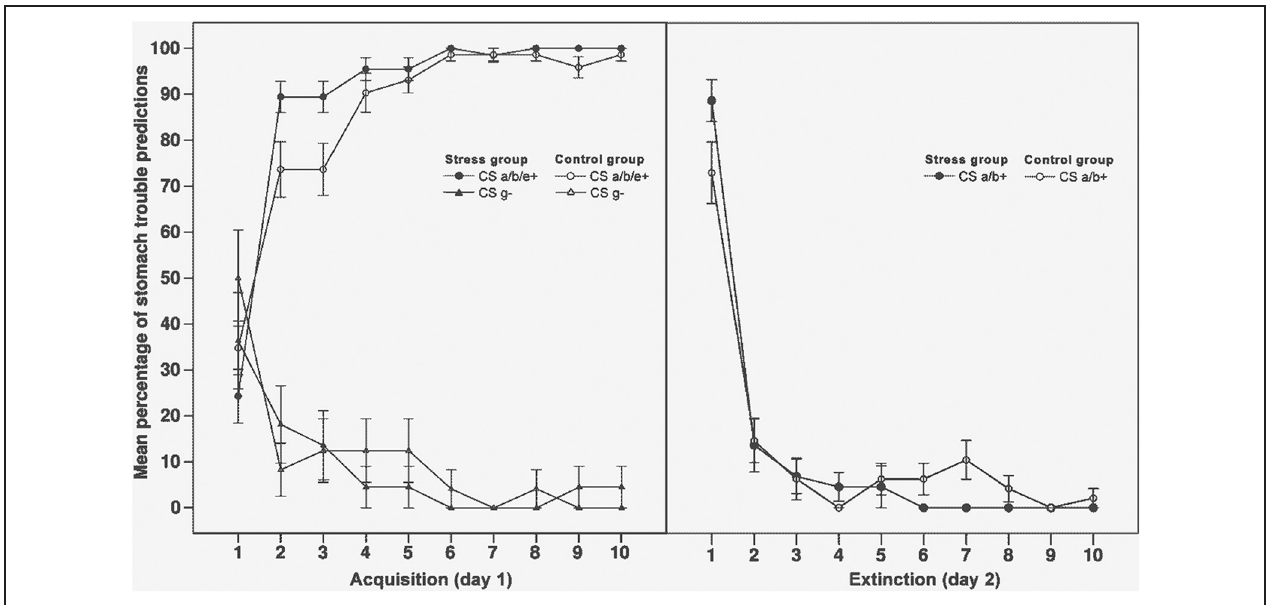
similar contingencies in this phase. CS e + and g − were not shown during extinction. CS a/b + were shown in context A during acquisition (day 1) and extinguished in context B (day 2). Error bars indicate standard errors of the